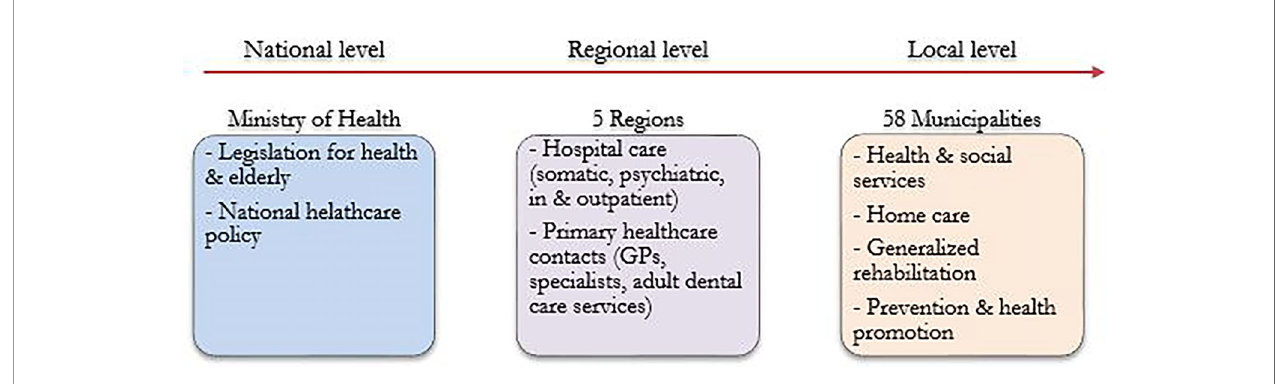
FIGURE 1 | The Danish healthcare system, an overview of responsibilities between the 3 levels (National, Regional and